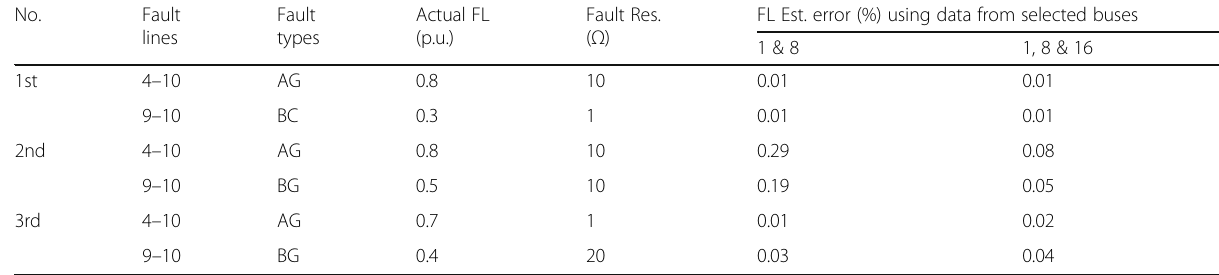
Table 9 Fault location results for multiple simultaneous faults involving untransposed line